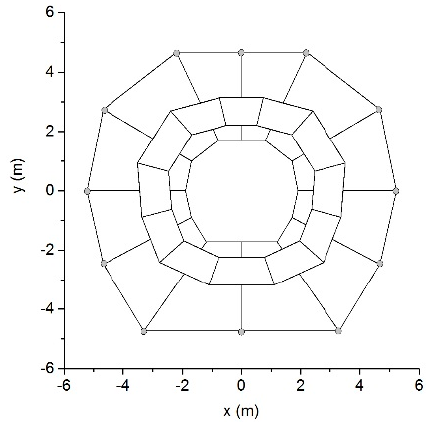
Figure 9. A surrounding rock model.